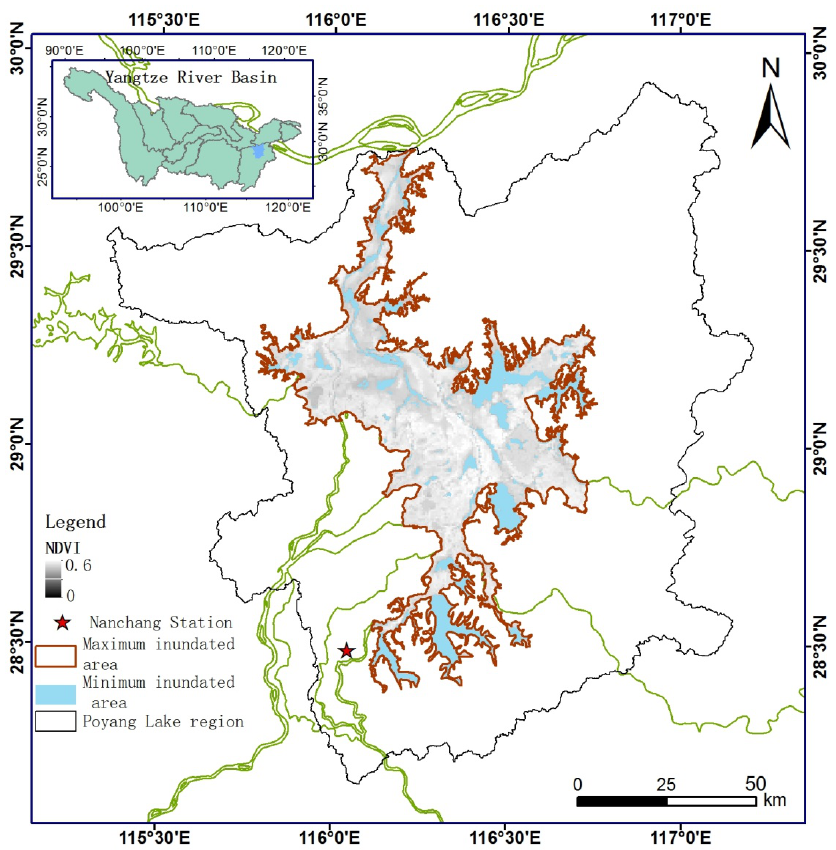
Figure 1. Geographic location of the Poyang Lake wetland delineated with its maximum and minimum water surface